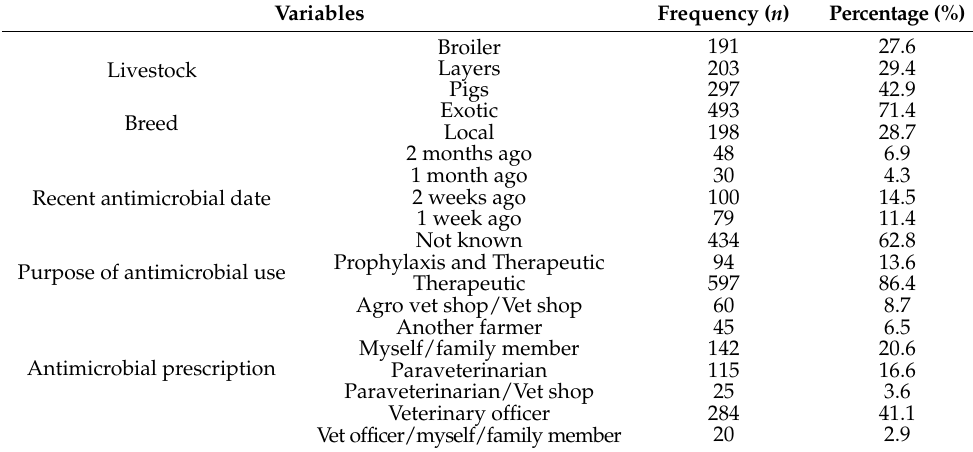
Table 1. Characteristics and AMU of livestock.